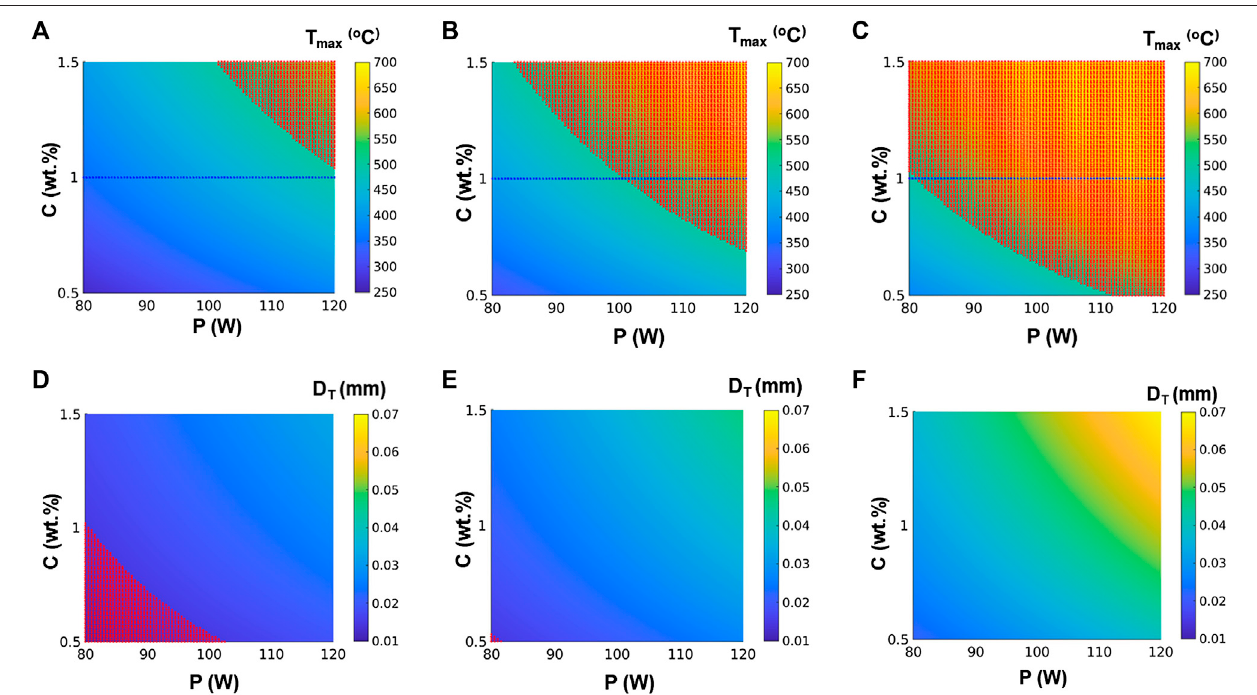
FIGURE 10 | Simultaneous effect of laser power and carbon black content on maximum weld temperature with constant parameters: (A) welding speed (cid:1) 1,400 mm/s, and diameter (cid:1) 2.1 mm, (B) welding speed (cid:1) 1,200 mm/s, and diameter (cid:1) 2 mm, (C) welding speed (cid:1) 1,000 mm/s, and diameter (cid:1) 1.9 mm, and their effect on the weld depth of transmissive layer with constant parameters: (D) welding speed (cid:1) 1,400 mm/s, and diameter (cid:1) 2.1 mm, (E) welding speed (cid:1) 1,200 mm/s, and diameter (cid:1) 2 mm, (F) welding speed (cid:1) 1,000 mm/s, and diameter (cid:1) 1.9 mm.